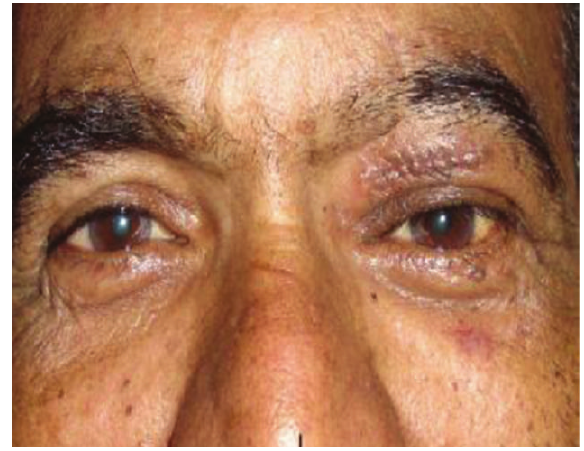
Figure 3: Postoperative photograph with sutures in